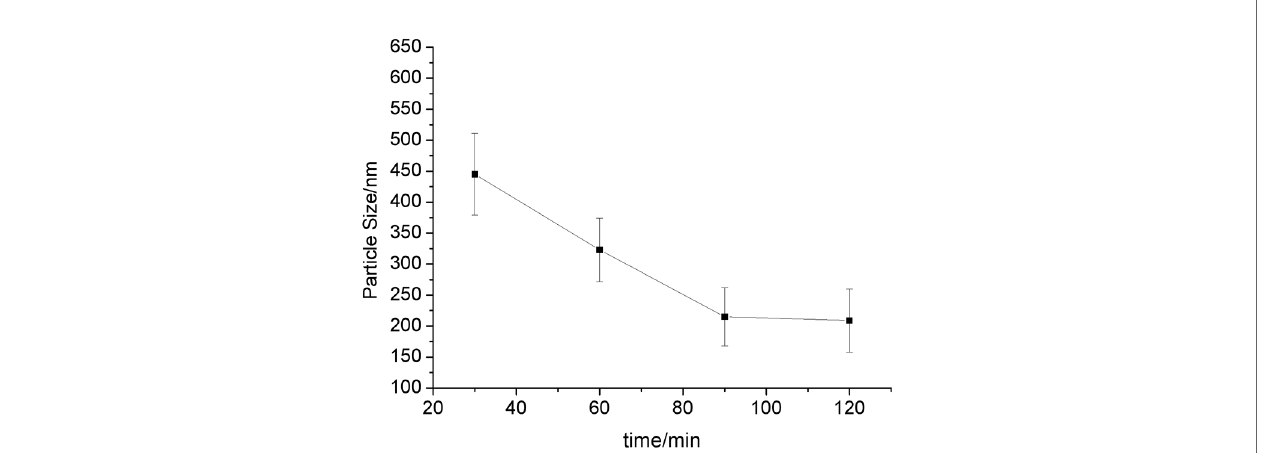
FIGURE 1 | Relationship between particle size and grinding time. The results are shown as line-chart images. The abscissa (X-axis) shows the grinding time points (min) and the ordinate (Y-axis) shows the particle size